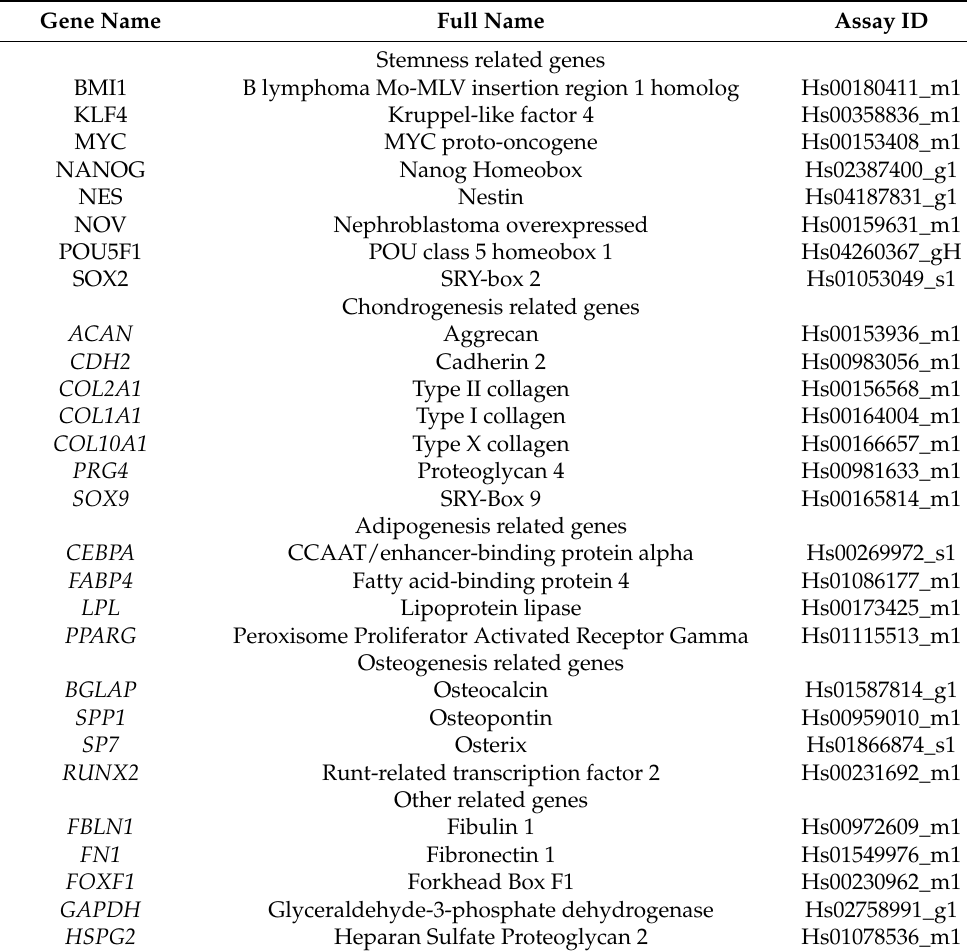
Table 1. Target genes’ Assay ID information for